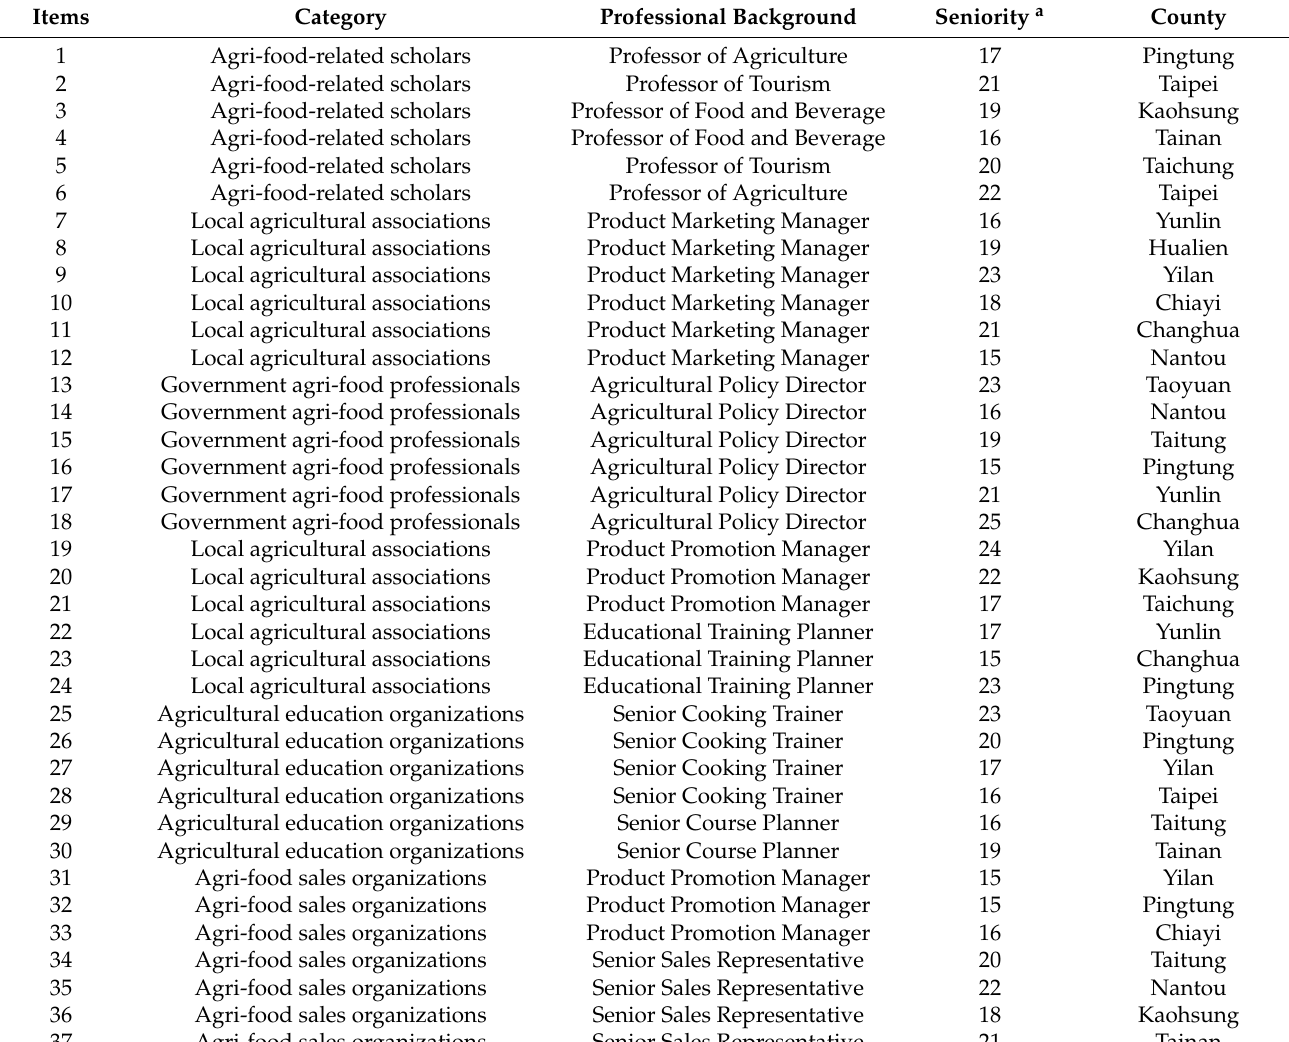
Table 1. Characteristics of the surveyed agricultural experts in Taiwan ( n =